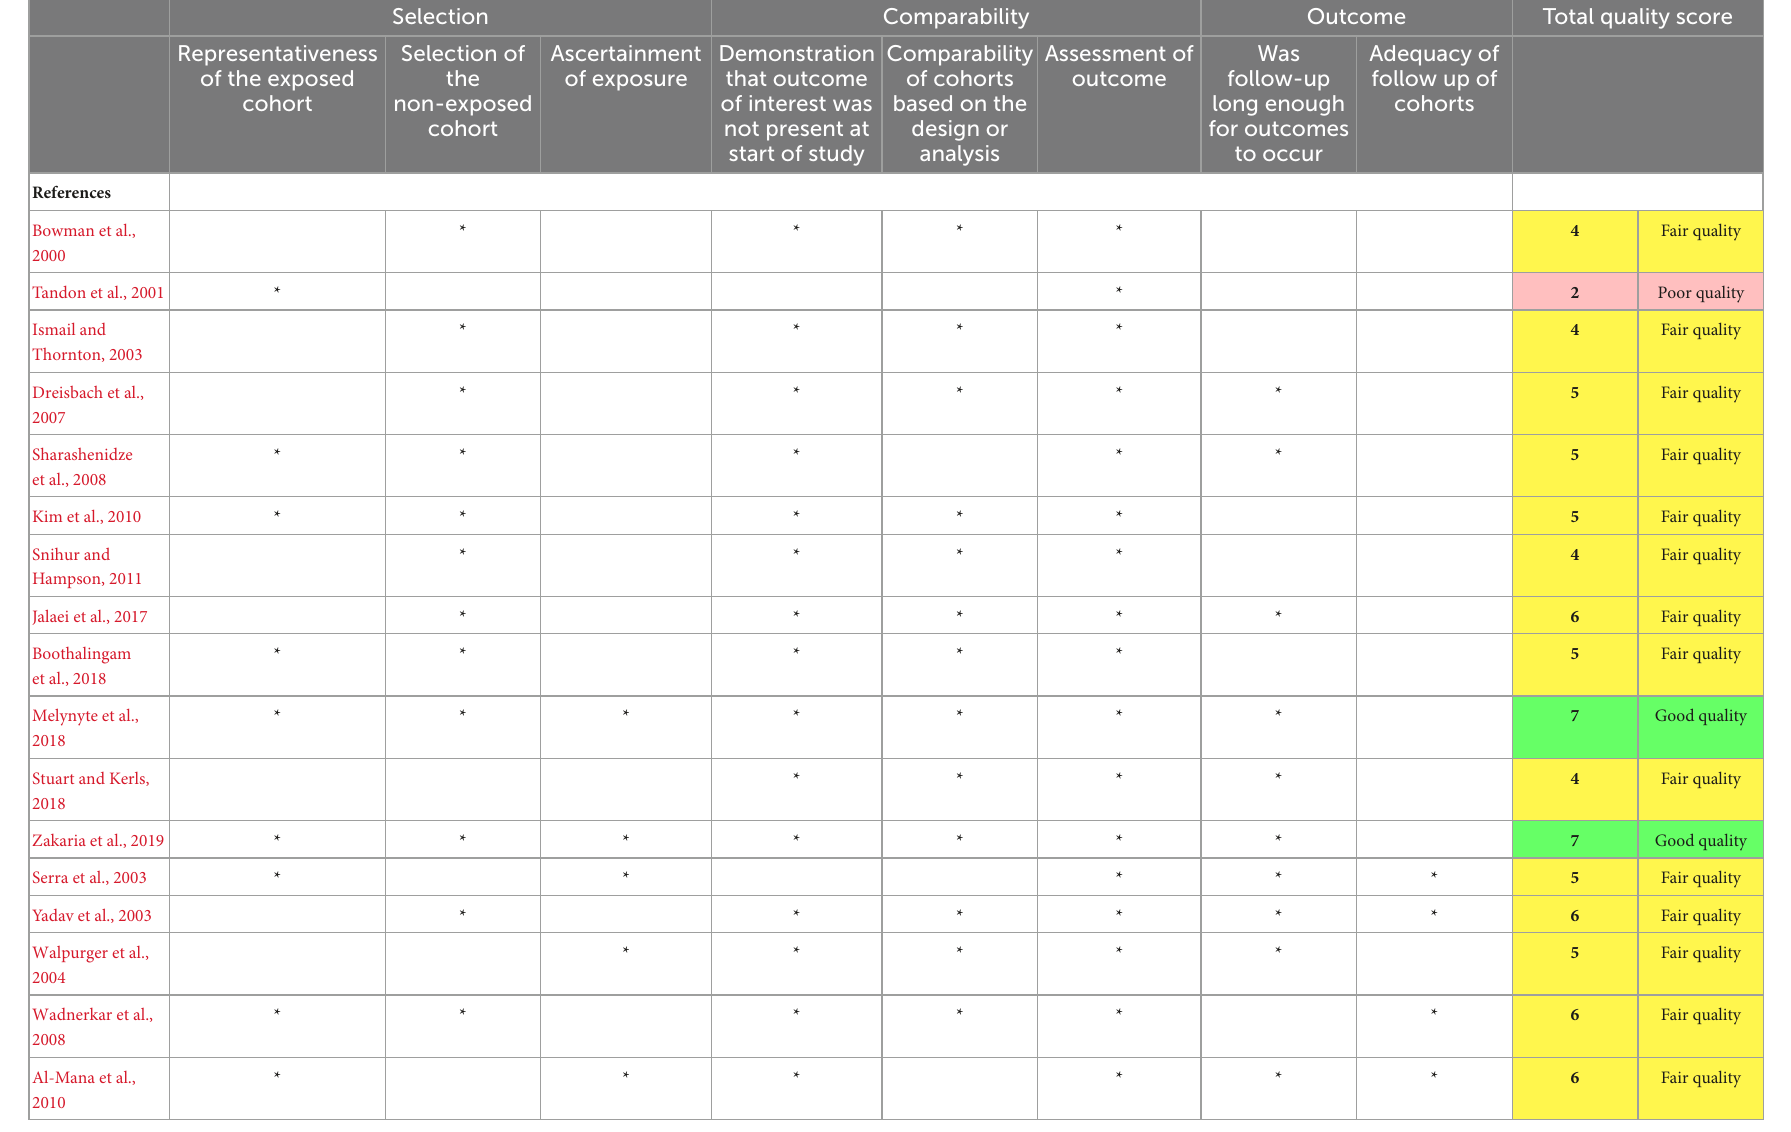
TABLE 5 Quality and risk of bias assessment (Newcastle–Ottawa Scale)